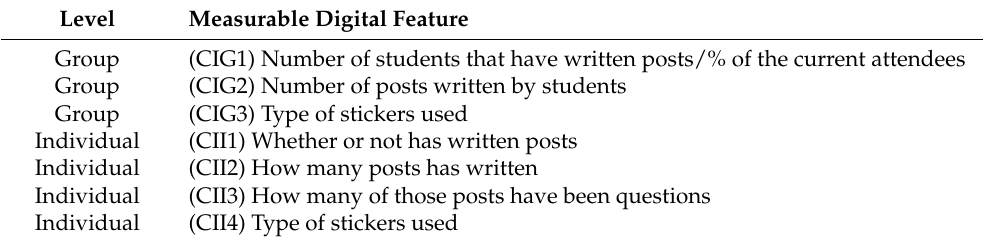
Table 12. Set of digital features defined for “chat interactions” category, corresponding to features B6, B14, B16 and E1.